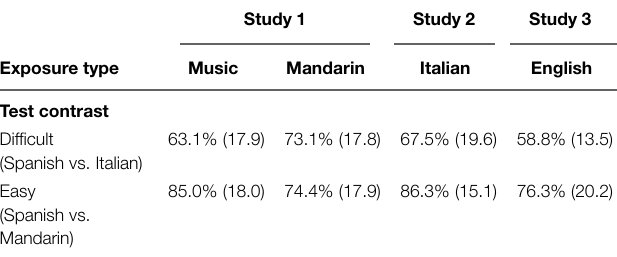
TABLE 1 | Mean percent correct and standard deviations, across all studies.